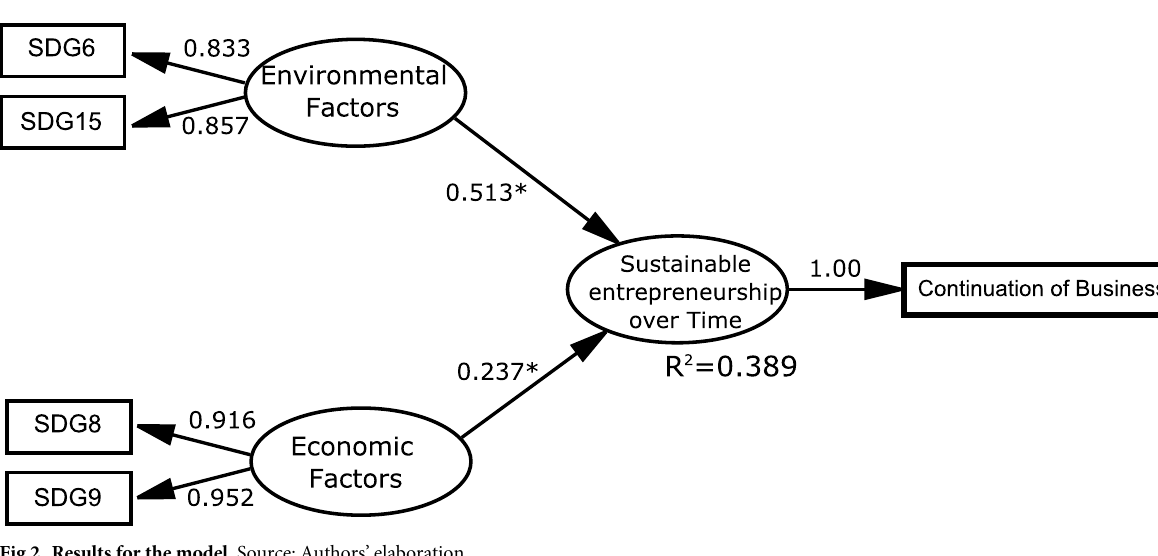
Fig 2. Results for the model. Source: Authors’ elaboration.